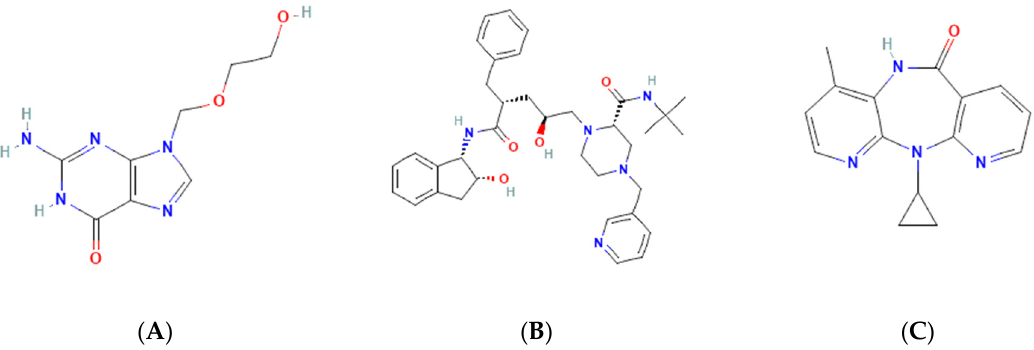
Figure 2. Molecular structure of ( A ) acyclovir [29], ( B ) indinavir [30], and ( C ) nevirapine [31]. Table 1. Summary of Antiviral Mechanism and Its Indication.